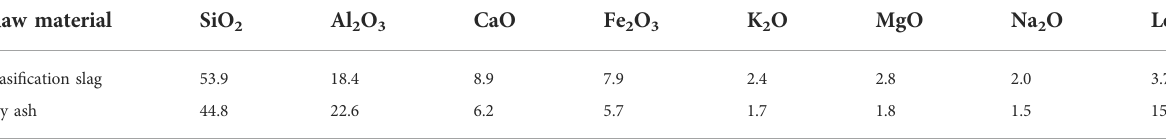
TABLE 1 Composition analysis of the raw materials (XRF unit:%).